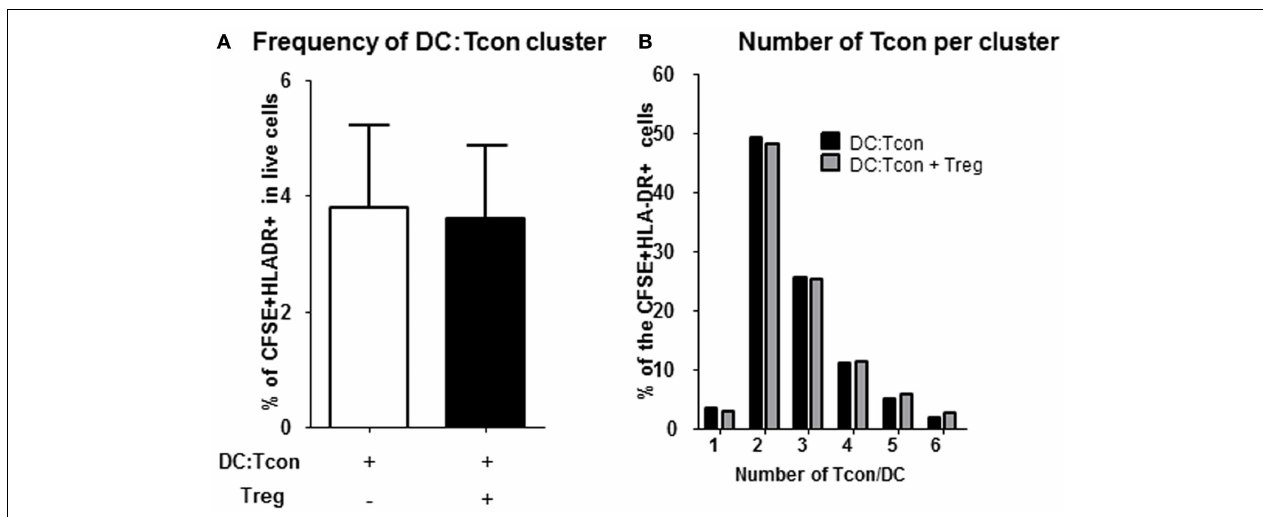
FIGURE 3 | RegulatoryT cells do not decrease formation of DC:Tcon clusters nor their composition . (A) Cluster frequency in the absence and presence ofTreg was quantified by flow cytometry ( n = 6). p Value corresponds to a paired t -test. (B) Number ofTcon in each DC:Tcon cluster was quantified by imaging flow cytometry, in the absence and presence ofTreg using a spot count analysis ( n = 925–1,115/condition). One representative experiment of 2 is shown.